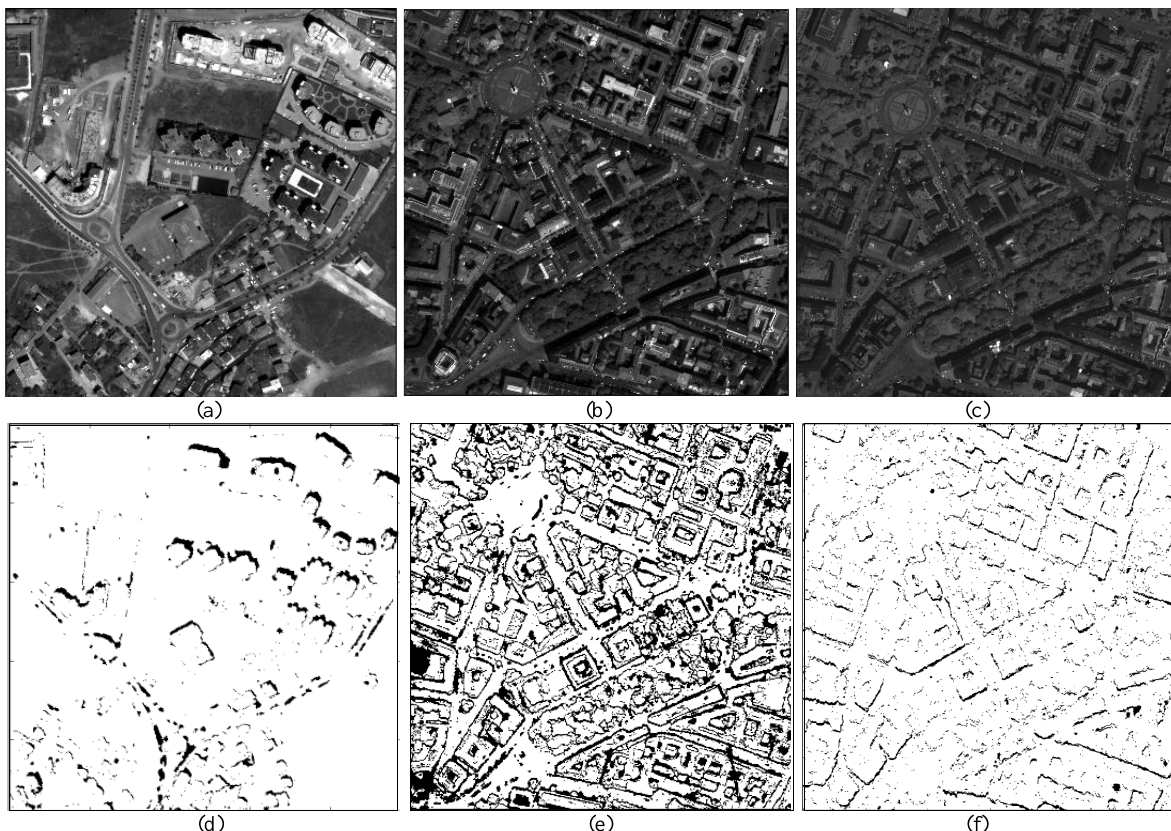
Figure 7. The three study area; (a, d) WV2 PAN from Istanbul and the voids in DSM,